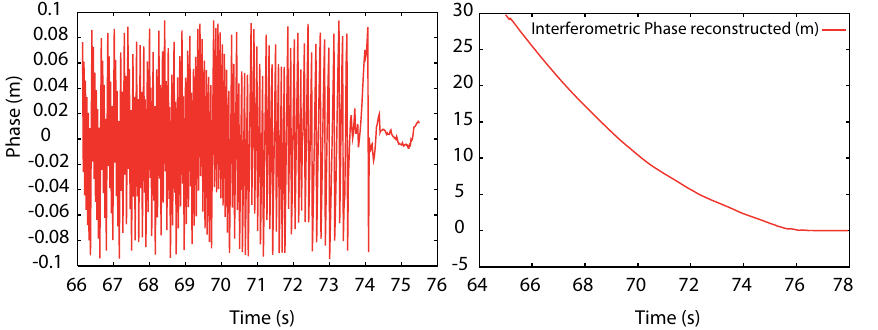
Fig. 4. Phase difference between the reference signal and the reflected signal (left). This phase difference can also be unwrapped removing the 2 π jumps to get the interferometric phase